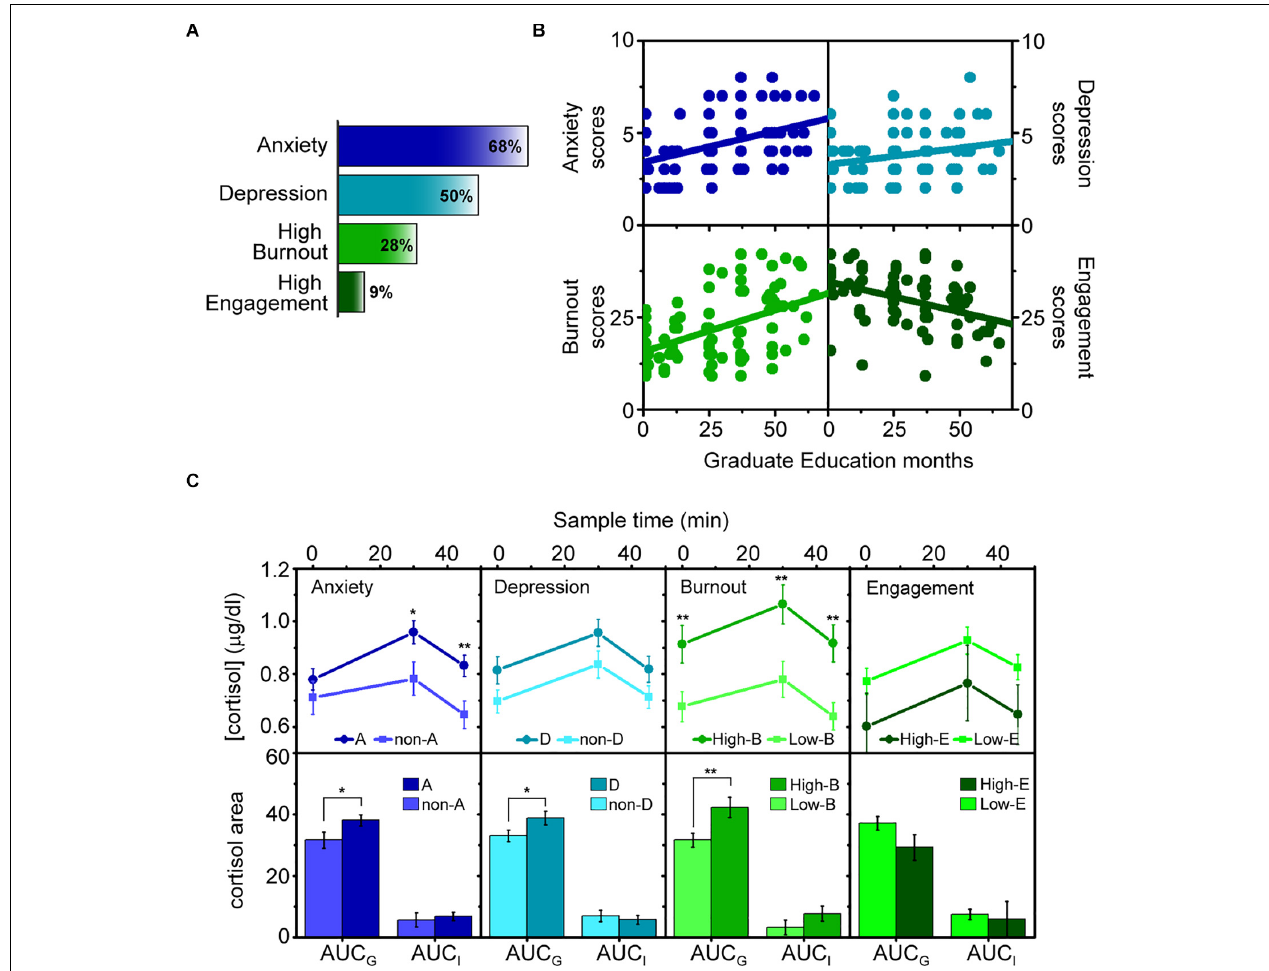
FIGURE 1 | Psychobiological assessment of work-related mental health issues in graduate students. (A) Prevalence of the work-related mental health issues within the population of graduate students analyzed. (B) Linear correlation of months of graduate education with Anxiety (Pearson r = 0.337, p = < 0.001), Depression (Pearson r = 0.195, p = < 0.05), Burnout (Pearson r = 0.454, p = < 0.001), and Work Engagement (Pearson r = − 0.424, p = < 0.001) scores among the students. (C) Comparison of the cortisol awaking response (CAR) and its respective indices (AUC G and AUC I ) between the different graduate student groups, i.e., graduate students with (A) and without anxiety symptoms (non-A), with (D) and without (non-D) depression symptoms, with High (High-B) and Low (Low-B) Burnout, and with High (High-E) and low (Low-E) work engagement. The graphs show mean values, with error bars representing the standard error of the mean. Statistical significance: * p < 0.05; ** p <